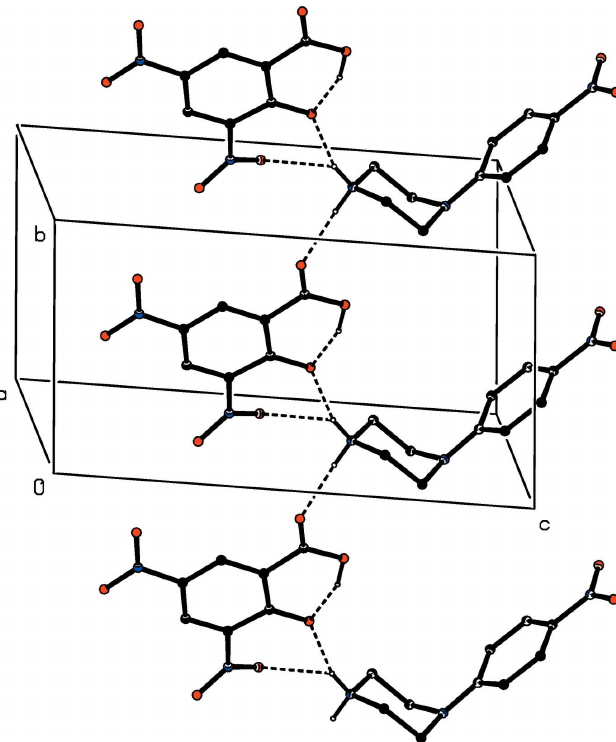
hydrogen bond (Table 2), and a two-centre N—H (cid:2) (cid:2) (cid:2) O hydrogen bond links these ion pairs into a chain of rings running parallel to the [010] direction (Fig. 5). There are four involving atom C145 (Table 2) links the ion pairs into a second